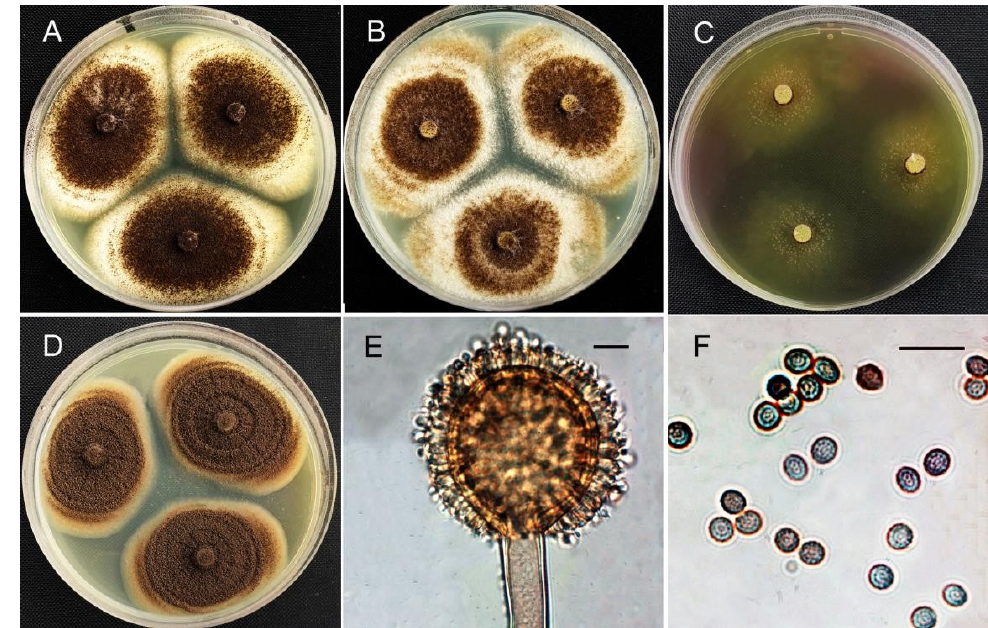
Figure 6. Aspergillus brunneoviolaceus HZ10. ( A ) Colonies on CYA after 7 days at 25 °C. ( B ) Colonies on MEA after 7 days at 25 °C. ( C ) Colonies on CREA after 7 days at 25 °C. ( D ) Colonies on CYA after 7 days at 37 °C. ( E ) Conidiophores . ( F ) Conidia. Scale bar = 10 μ m.